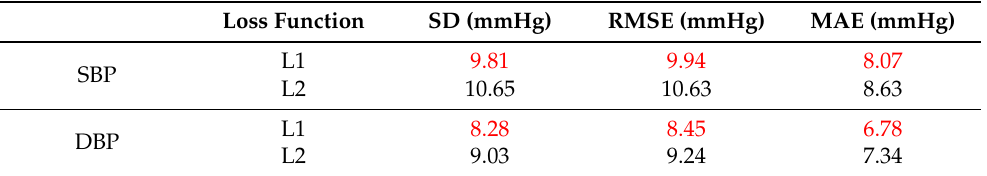
Table 4. Comparison of the performance of different loss